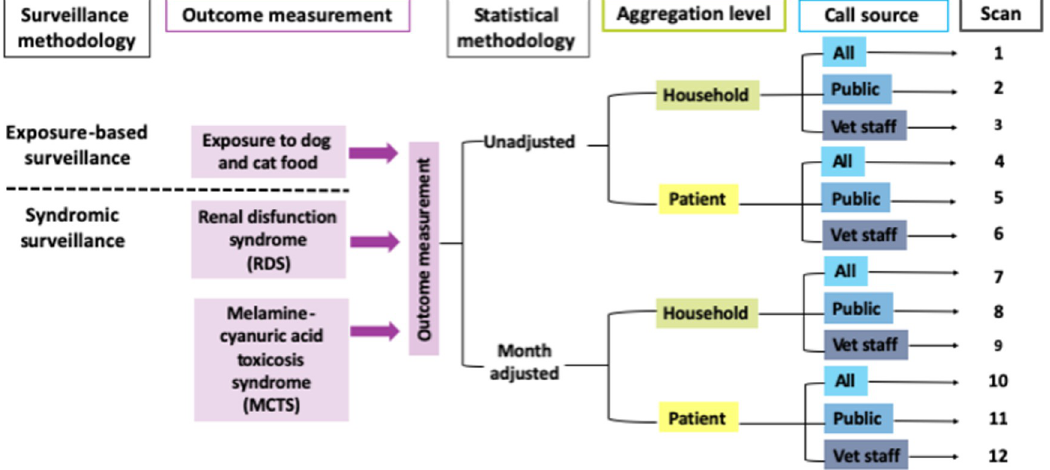
Fig 2. Flow chart of the 12 scans conducted for each outcome measure and combination of surveillance outcome, statistical methodology, data aggregation level and call source.